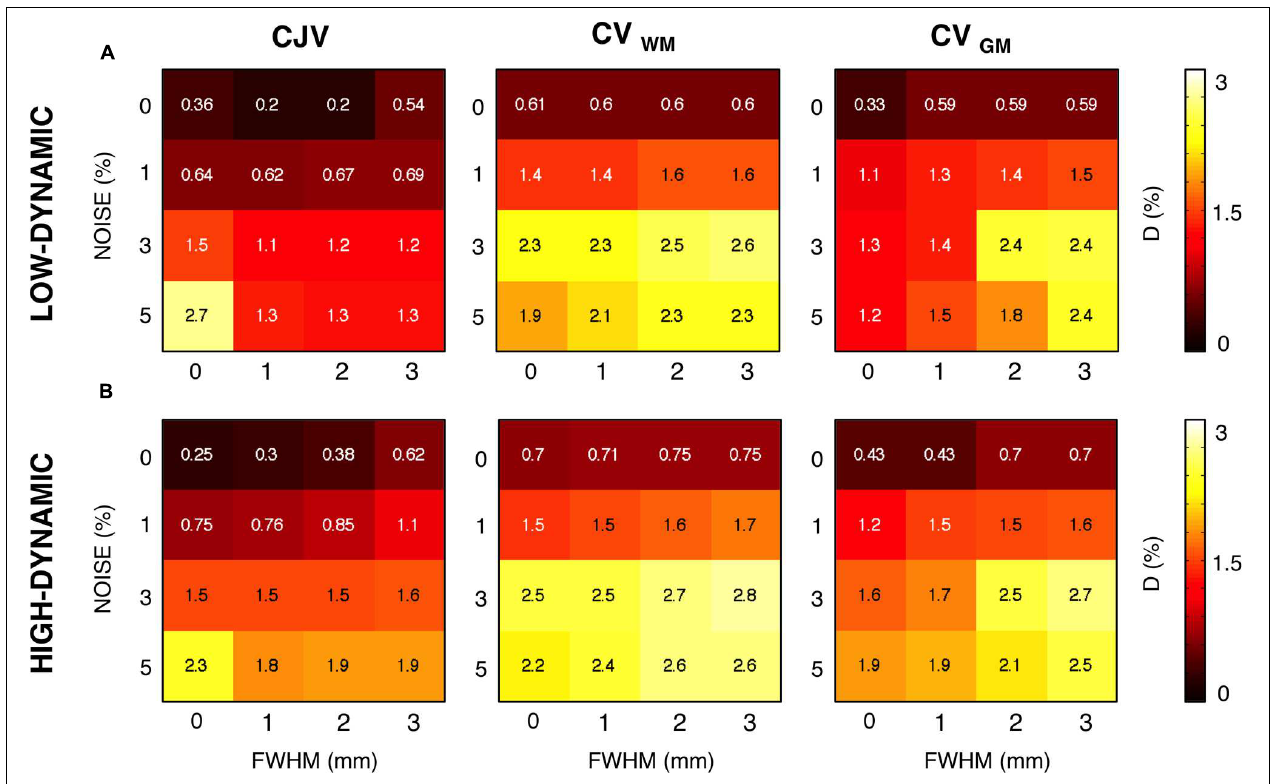
FIGURE 5 | Relation between spatial smoothing and image noise. We assessed the relation between image noise and amount of smoothing applied after INU correction. The voxel-wise distance D between the simulated and the estimated INU fields was computed. We report in this figure the results for the parameter configuration identified by each metric. CJV, CV WM , and CV GM were compared for the low-dynamic (A) and high-dynamic (B) INU